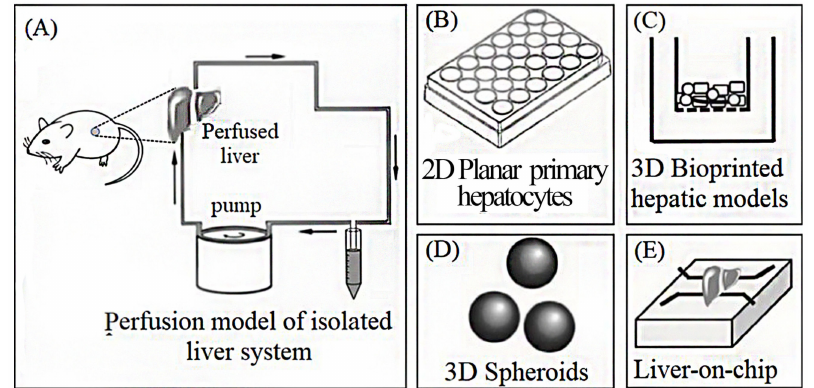
Figure 2. Liver models used commonly in vitro. ( A ) Perfusion model of an isolated liver system; ( B ) 2D planar primary rat hepatocytes; ( C ) 3D-printed liver tissue; ( D ) 3D spheroids; ( E )